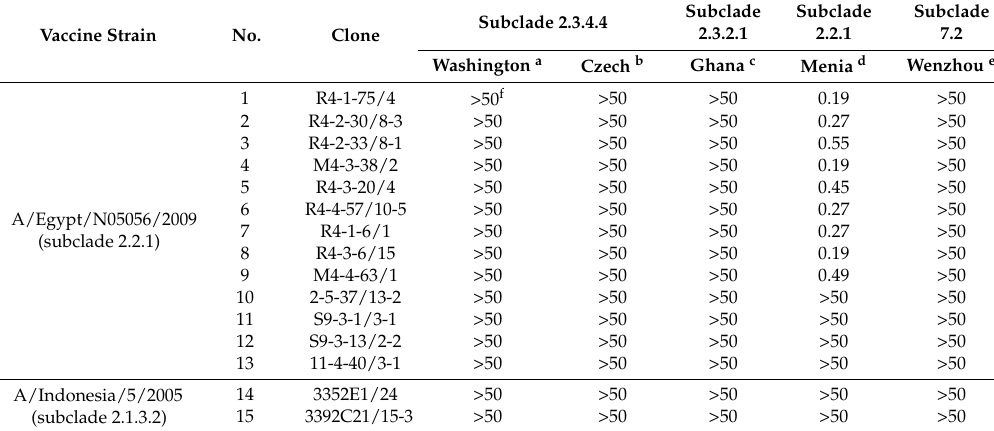
Table 5. Neutralizing activity of the human mAbs.